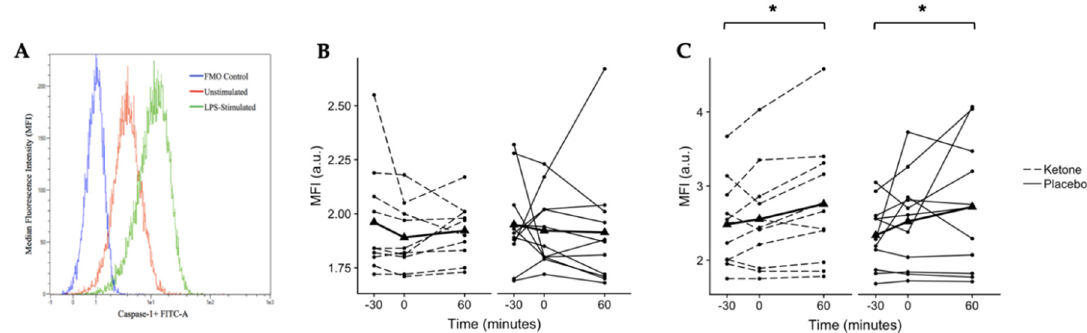
Figure 2. Median fluorescence intensity (MFI) representative of active caspase-1 in human monocytes as quantified by flow cytometry. (A) Histogram comparing MFI of a fluorescence minus one (FMO) control, an unstimulated sample, and an lipopolysaccharide (LPS)-stimulated sample. (B) No changes were observed in unstimulated human monocytes. (C) A significant main effect of time was found ( p = 0.043) for LPS-stimulated human monocytes with post hoc testing revealing significantly higher caspase-1 activation at 60 vs. − 30 min (* p = 0.013, Bonferroni-corrected pairwise comparison). Individual participant data are shown with the ketone condition represented by dashed lines and the placebo condition represented by solid lines. Means are shown by bold lines with triangles. n = 11.